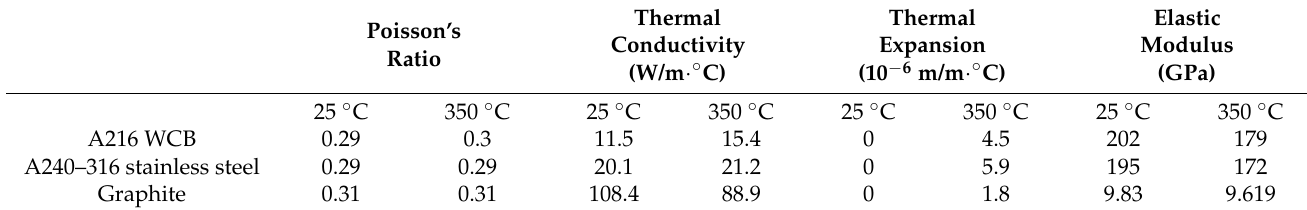
Table 2. Material properties of QOBV.